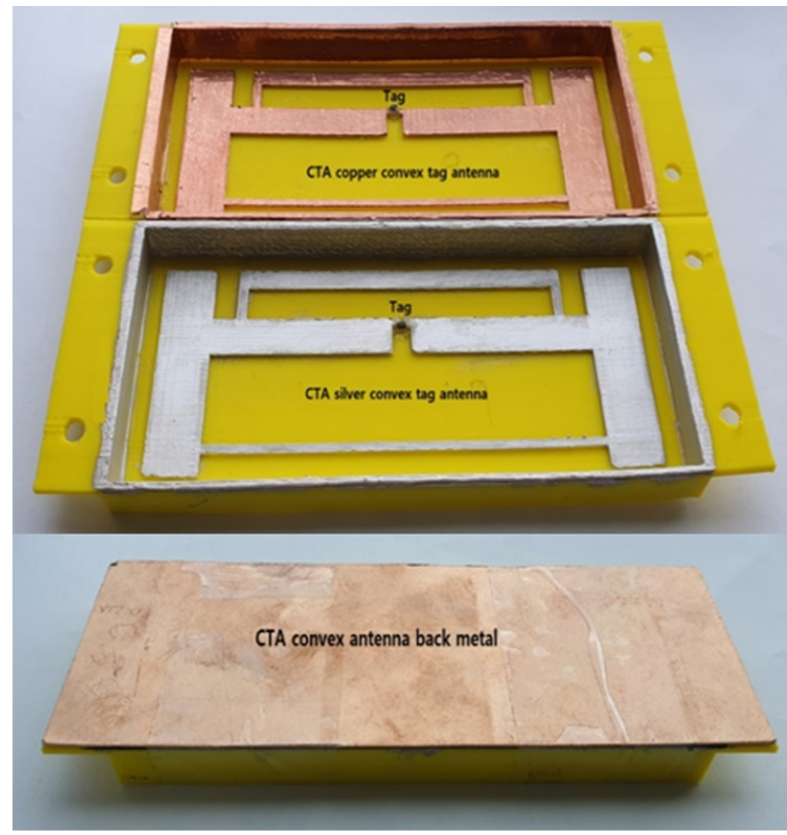
Figure 12. Fabricated copper and silver painted tag antenna (ant_h = 9 mm).